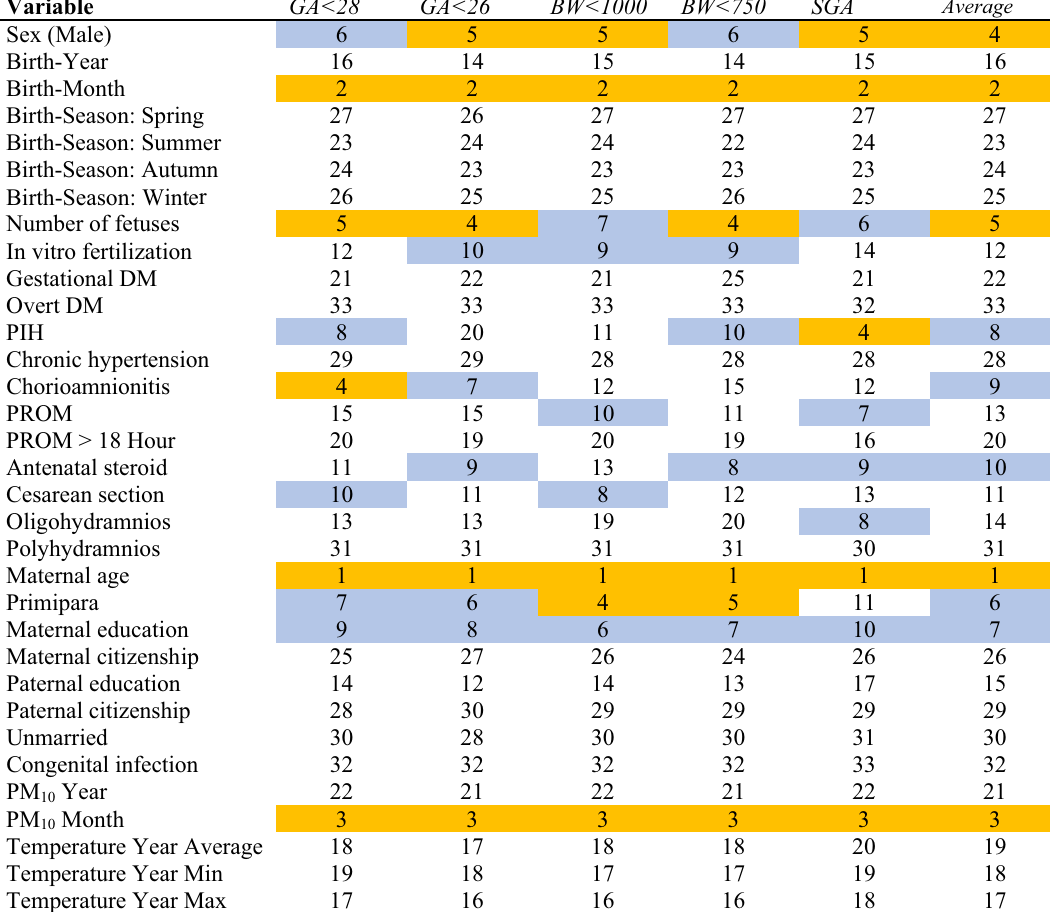
Table 6. Random forest variable importance rankings for adverse birth outcomes: PM 10 included. The ranking of a top-5 predictor was highlighted with the color of orange and 6–10 predictor was highlighted with the color of mild blue. BW, birth weight (grams); DM, diabetes mellitus; GA, gestational age (weeks); PIH, pregnancy- induced hypertension; PM, particulate matter; PROM, prelabor rupture of membranes; SGA, small-for- gestational age. * P < 0.10 chi-square or T test (Table